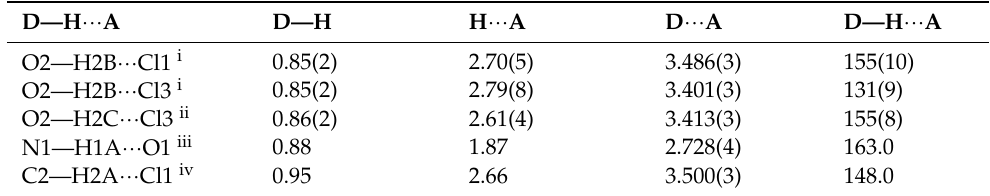
Table 4. Hydrogen-bond geometry for I at 100 K (Å, ◦